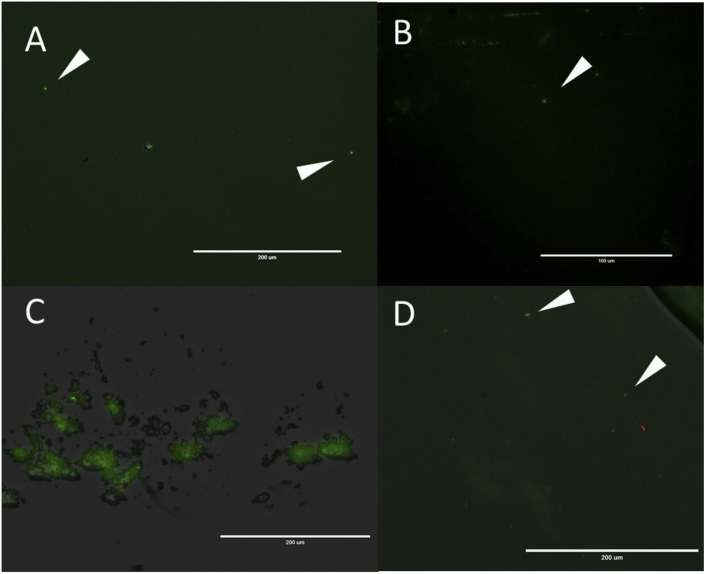
SYBR® Green I by fluorescent microscopy in TE buffer: A) 0.5x; B) 1x; C) 2x; D) 5x. Red dots – 0.2 μm crimson FluoroSpheres®. Arrows indicate SYBR-colloid particles. (For interpretation of the references to colour in this figure legend, the reader is referred to the Web version of this article.)